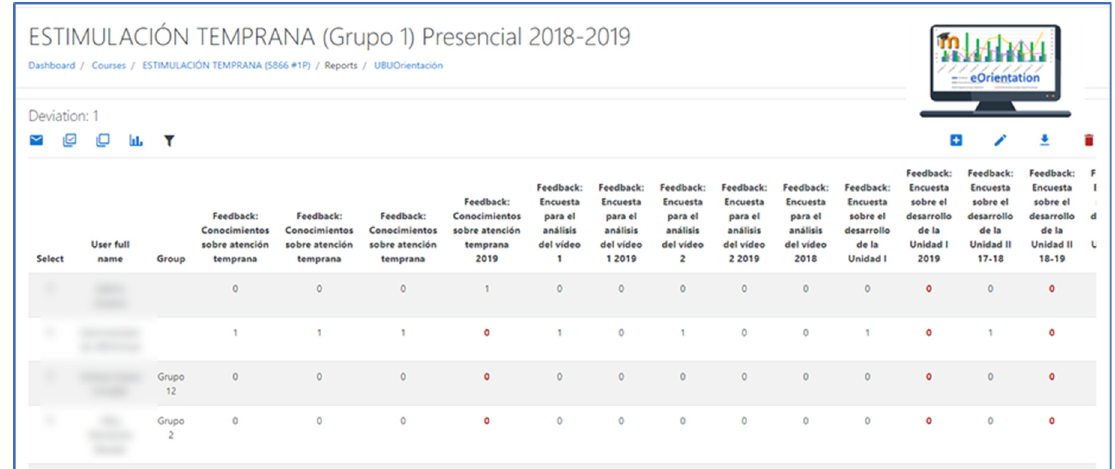
Figure 5. Detection of frequencies below the pre-set level (standard deviation) applied by the teacher to each activity.